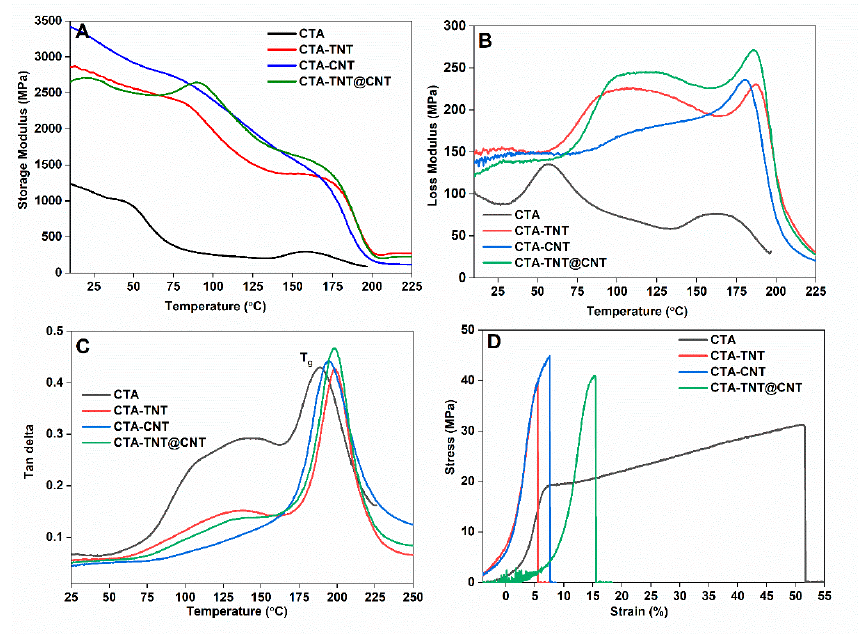
Figure 6. ( A ) Change in storage modulus; ( B ) loss modulus; ( C ) Tan delta as a function of temperature; and ( D ) stress–strain plot for the synthesized membranes.